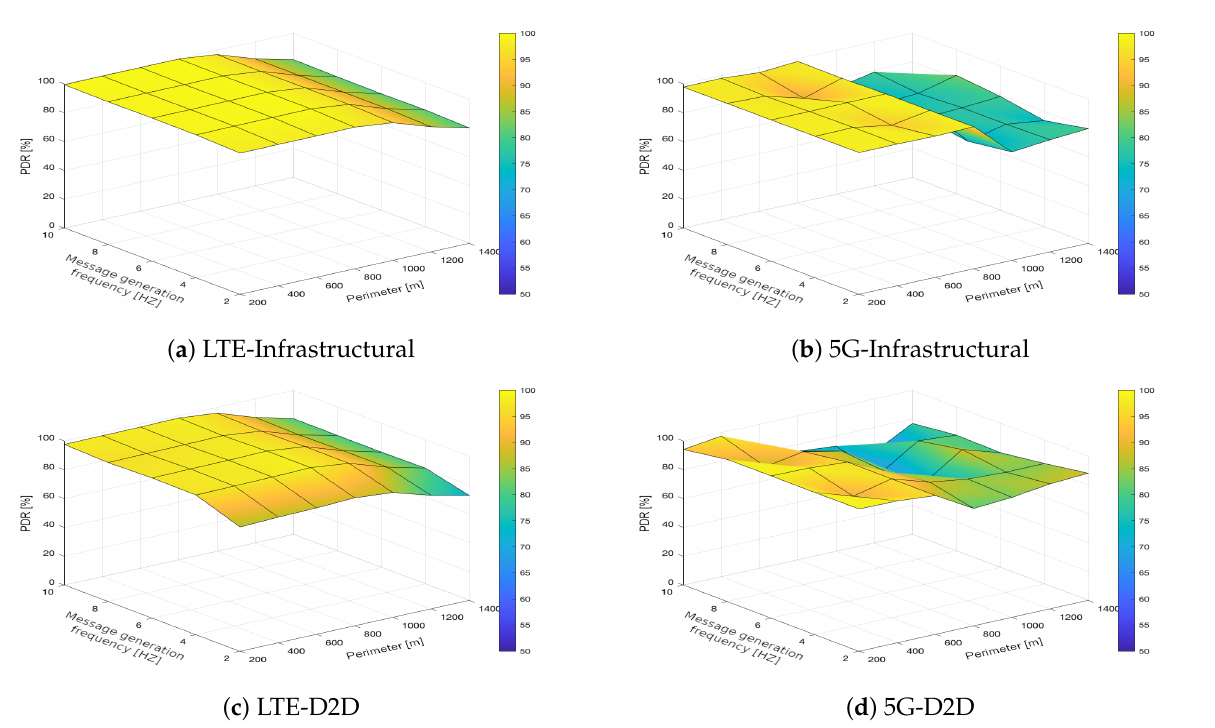
Figure 4. PDR simulated for all the investigated modes of the 4G-based and 5G-based C-V2X technologies and traffic intensity of 750 vehicles per hour.